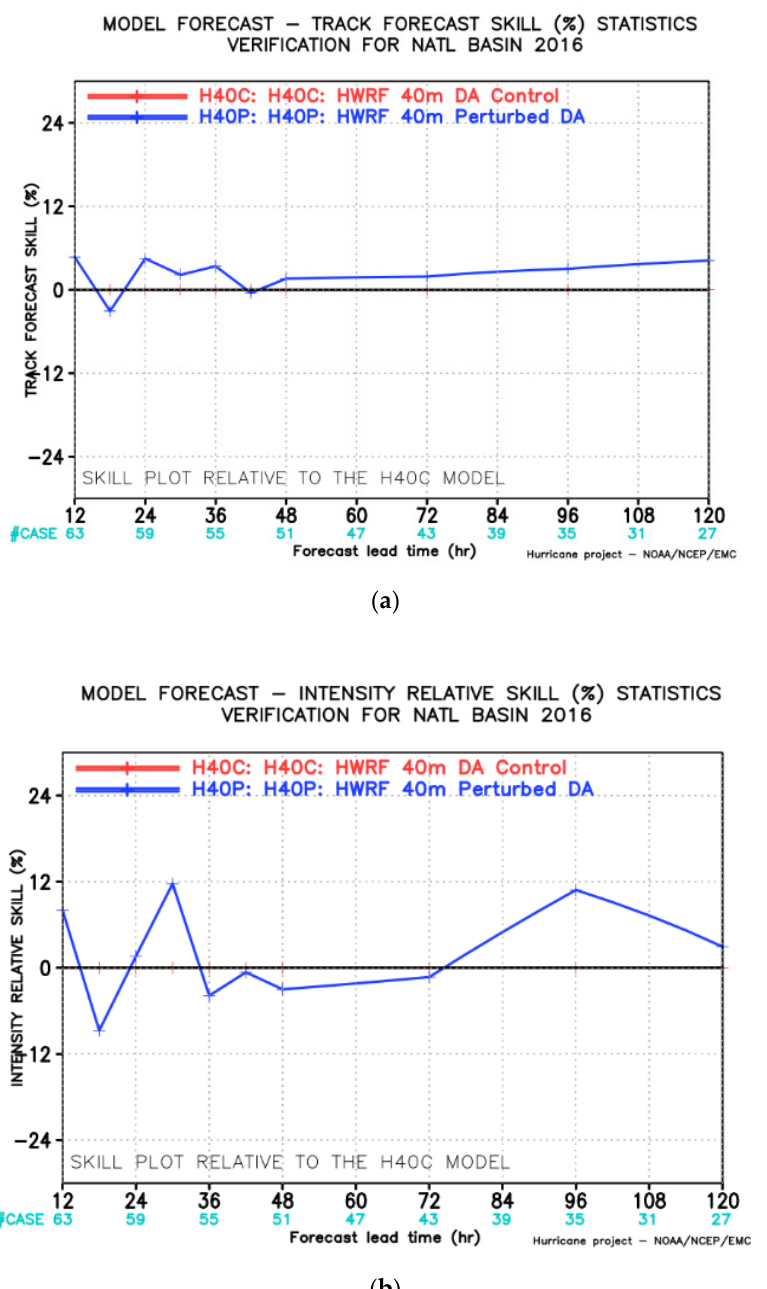
Figure 12. Forecast skill improvements of the experiment with the (H40P) and without the (H40C) stochastic model physics in the self-cycled DA, for the track ( a ) and intensity ( b ) forecasts, TDR storms only, Hurricane Hermine and Matthew, 2016 .